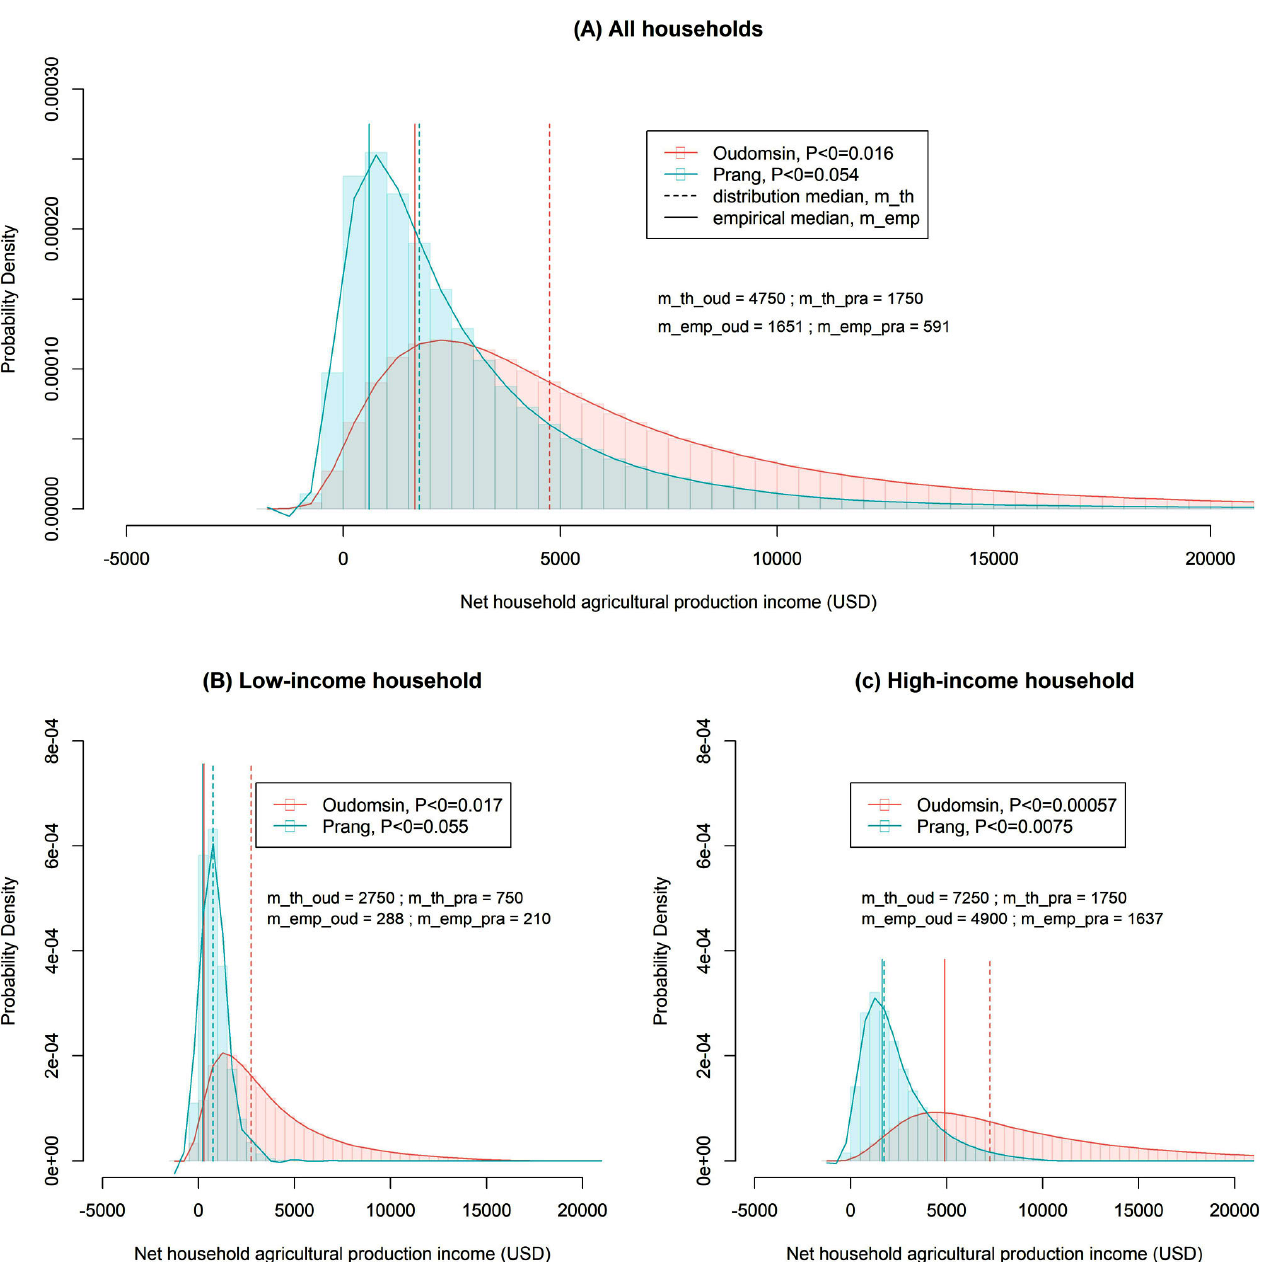
Fig. 4 . Probability distribution of net household agricultural production income in each case study area (output from the Bayesian network [BN] model) for (A) for all households, (B) an average low-income household, and (C) an average high-income household in Oudomsin (oud) and Prang (pra). The dashed lines indicate the modeled (theoretical) median of the distribution (m_th), and the solid lines indicate the empirical median of 2017 (m_emp). Smoothing curves are added to the discretized probability distribution